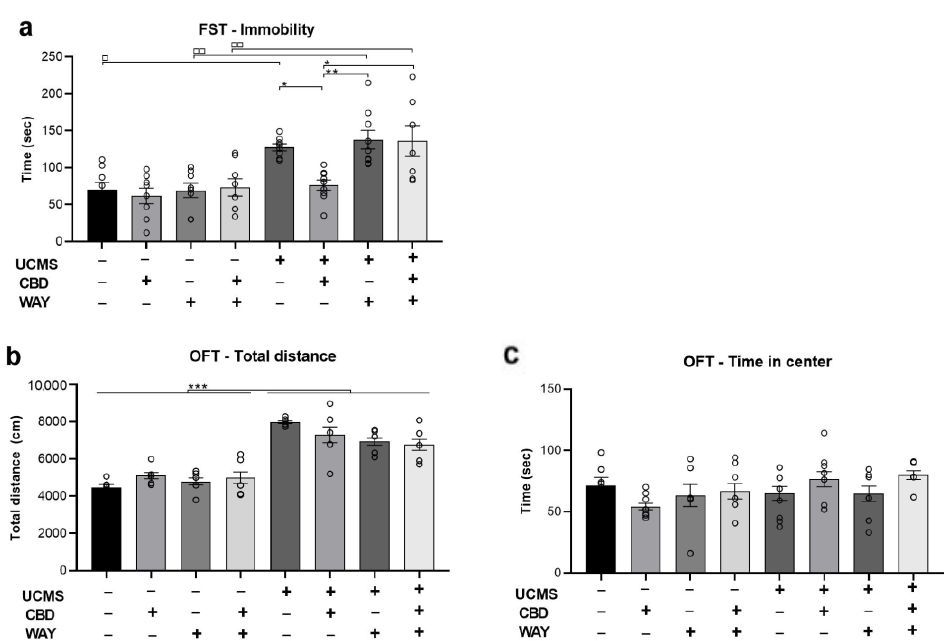
Figure 4. The effects of the 5-HT1a antagonist WAY100635 on behavior in rats exposed to UCMS and treated with CBD. ( a ) FST: UCMS rats that were treated with CBD, spent less time immobile than UCMS rats that were treated with vehicle, WAY, or CBD + WAY. Furthermore, UCMS rats treated with vehicle, WAY, or CBD + WAY, showed increased immobility compared to No UCMS rats injected with vehicle, WAY, or CBD + WAY, respectively. ( b ) OFT: UCMS rats traveled more than No UCMS rats. ( c ) OFT time in the center: no differences between groups were observed. FST — forced swim test; OFT — open field test; UCMS: unpredictable chronic mild stress; CBD: cannabidiol; WAY: WAY100635, *, p < 0.05; **, p < 0.01; ***, p < 0.001; compared to UCMS-CBD group (cid:3) *, p < 0.05, (cid:3)(cid:3) **, p < 0.01, (cid:3)(cid:3)(cid:3) ***, p < 0.001 white aquares indicate statistical significance in UCMS vs. NO UCMS